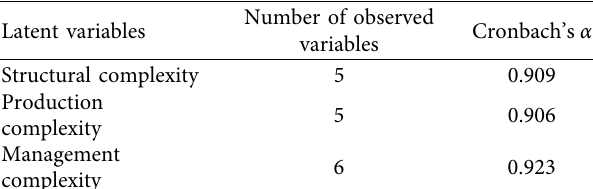
Figure 2: Theoretical model of the influence of PC component complexity on production efficiency. Table 7: Reliability test of latent